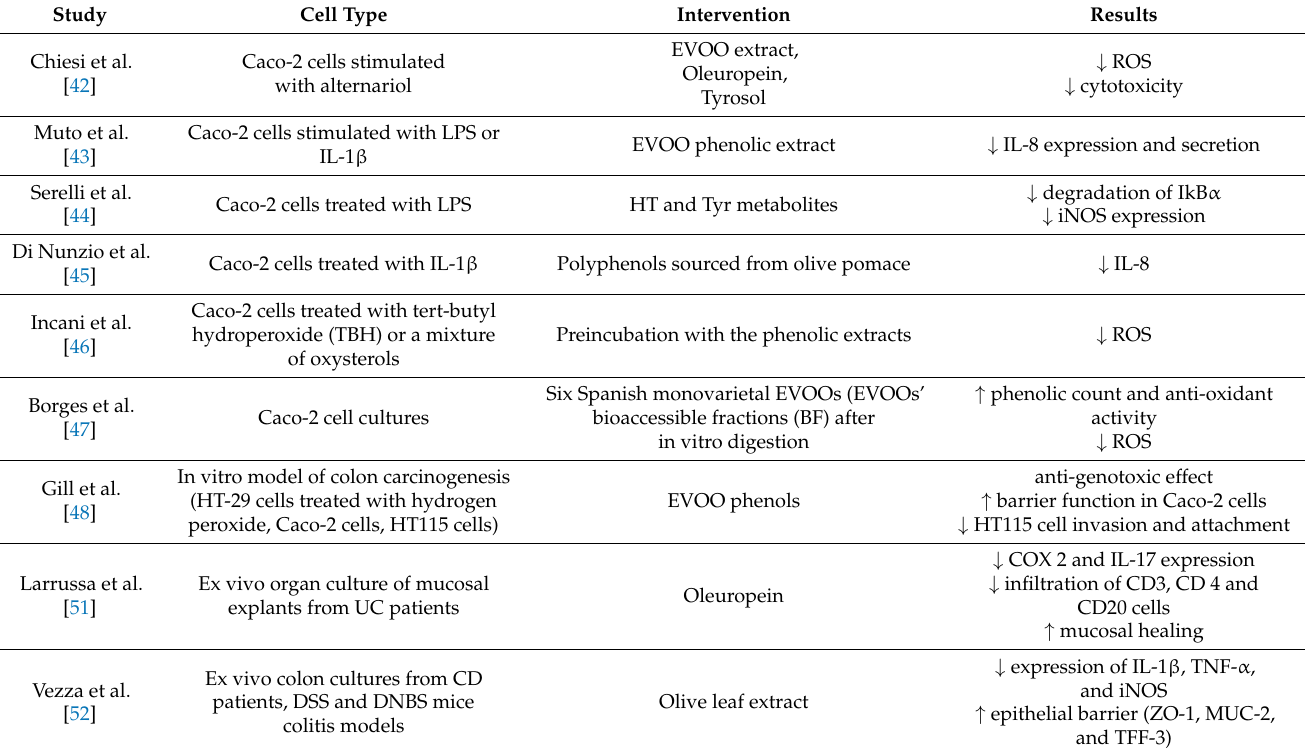
Table 1. In vitro studies on olive oil polyphenols and intestinal